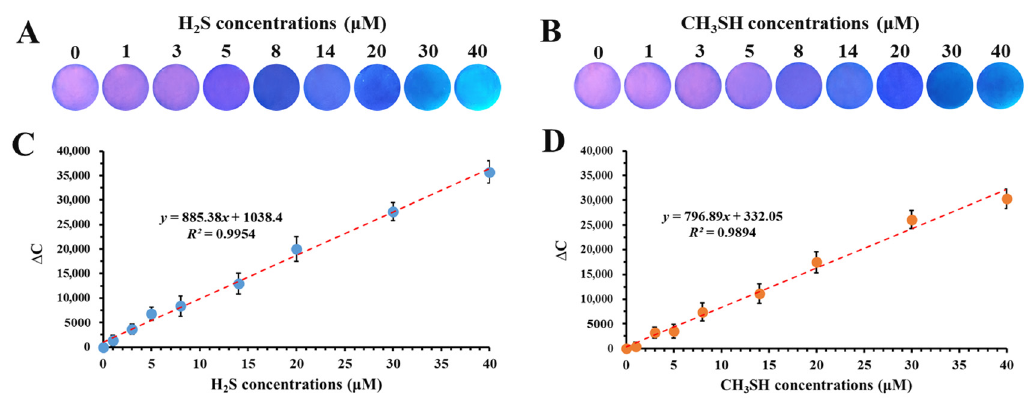
Figure 7. The fl uorescence change of the SiQD − AgNC/PVDF fi lm in response to ( A ) H 2 S and ( B ) Figure 7. The fluorescence change of the SiQD-AgNC/PVDF film in response to ( A ) H 2 S and CH 3 SH. The relation between ∆ C of SiQD − AgNC/PVDF fi lm and the concentrations of ( C ) H 2 S and ( B ) CH 3 SH. The relation between ∆ C of SiQD-AgNC/PVDF film and the concentrations of ( C ) H 2 S ( D ) CH 3 SH. and ( D ) CH 3